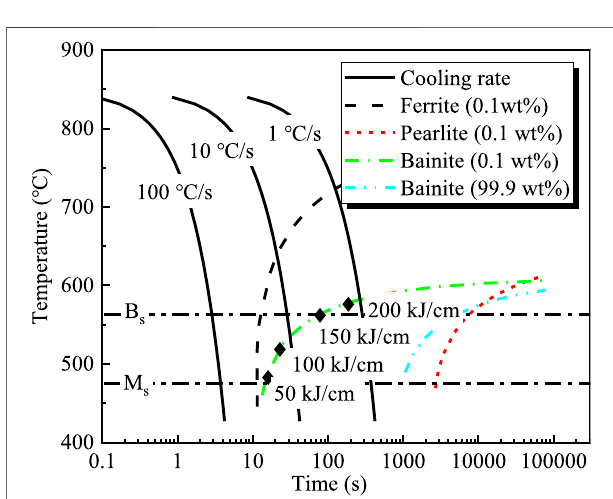
FIGURE 13 | Continuous cooling transition curves at different cooling rates calculated by the thermal-dynamic software Jmatpro.